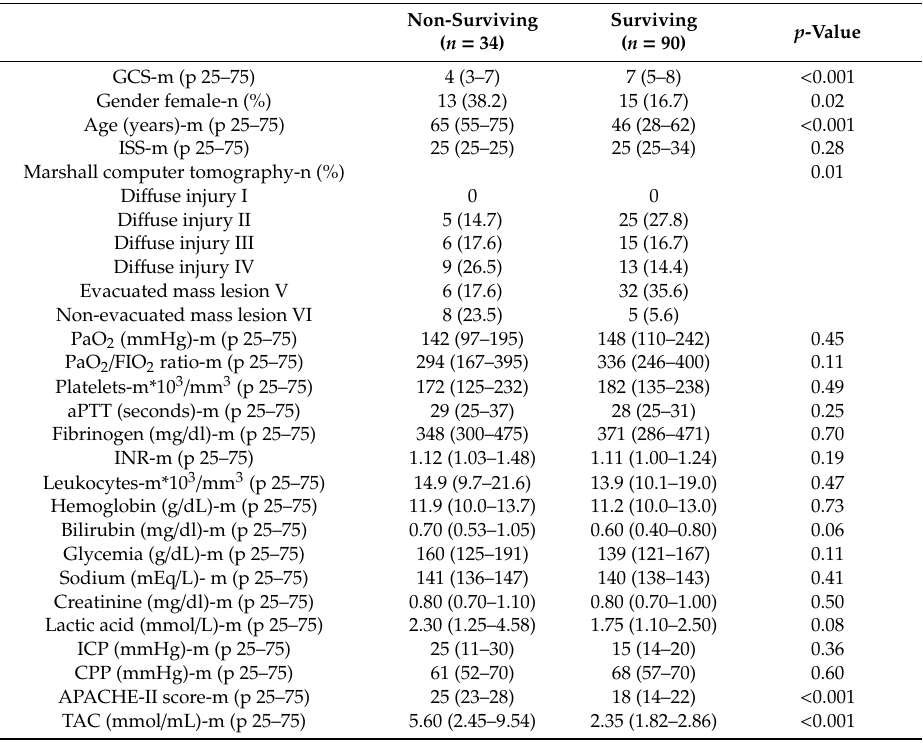
Table 1. Characteristics on admission of 30-day surviving and non-surviving patients.